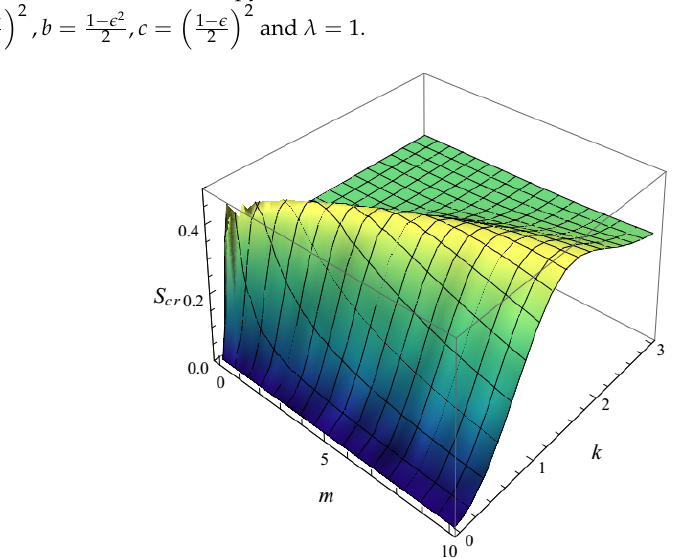
Figure 3. Particle creation entropy, S cr , as a function of momentum k and mass m for radiation dominated universe.